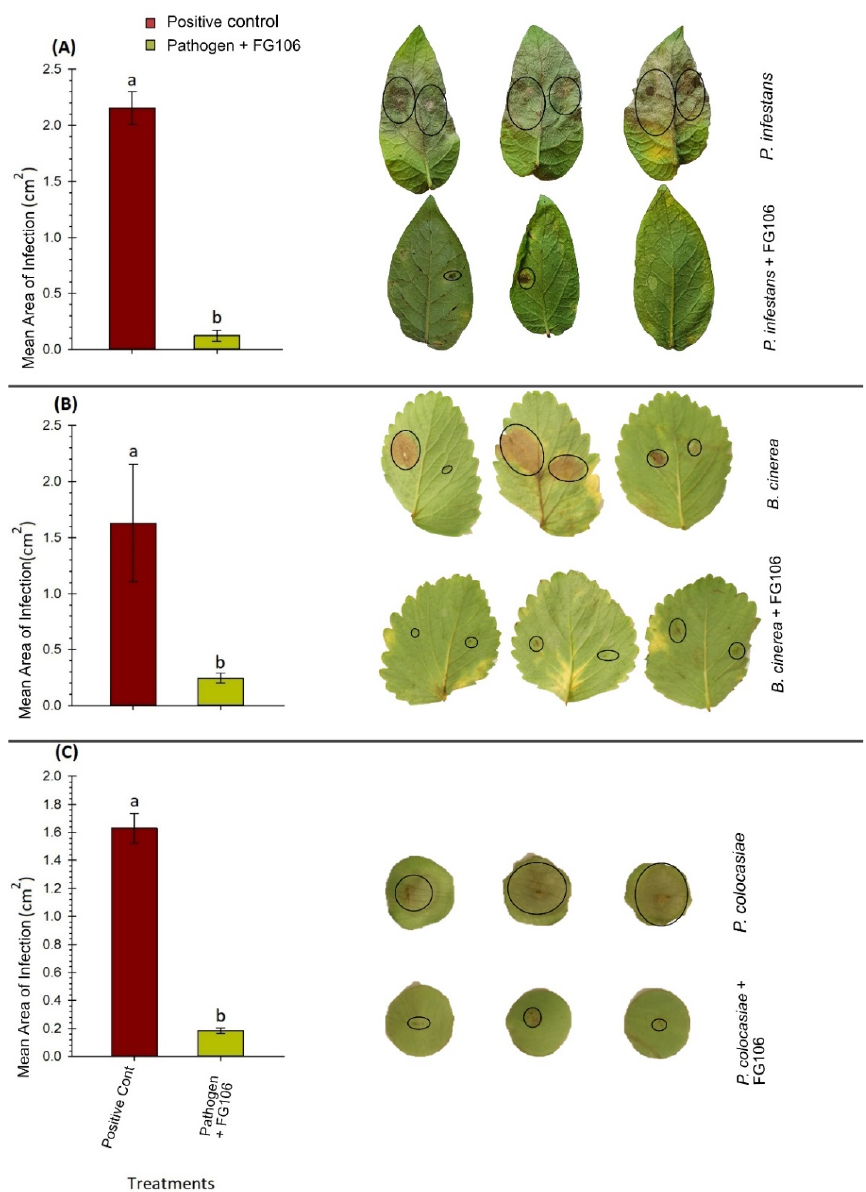
Figure 5. Detached leaf assay (DLA) measuring the antagonistic activity of the FG106 against ( A ) Phytophthora infestans on potato leaves ( n = 16), ( B ) Botrytis cinerea on strawberry leaves ( n = 12), and ( C ) Phytophthora colocasiae ( n = 15) on taro leaves. In all cases, the area exhibiting symptoms was quantified using ImageJ. Data represent means ± standard deviation of 6 replicates. Means labelled with different letters differ significantly according to Student’s t test at p < 0.01).